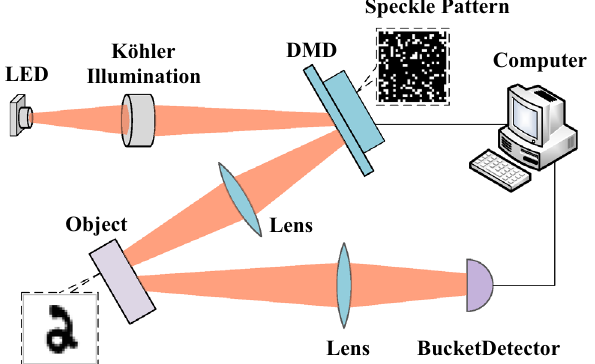
Figure 1. Conceptual diagram of a computational ghost imaging system. The light is spatially shaped via a DMD into speckle patterns which illuminate the object. The overall scattered light from the sample is acquired via a bucket detector and the signal is feed into the optimisation loop.